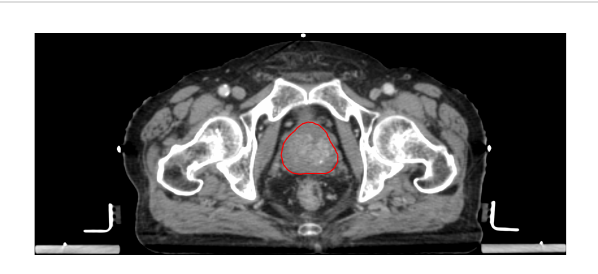
FIGURE 2 Representative example of a GTV segmentation on contrast- enhanced pCT of a high-risk prostate cancer